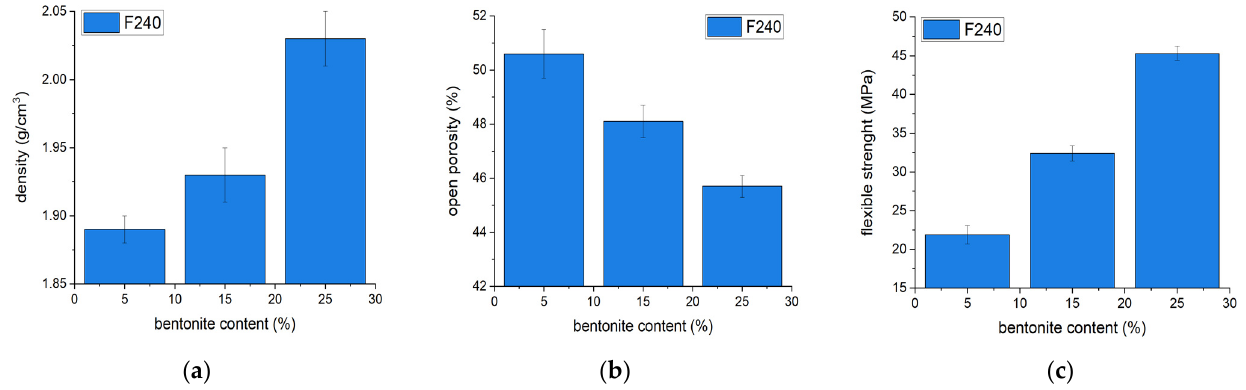
Figure 12. Content of bentonite binder vs. ( a ) density, ( b ) open porosity, and ( c ) flexible strength of ceramics based on electrocorundum F240 prepared by slip casting.